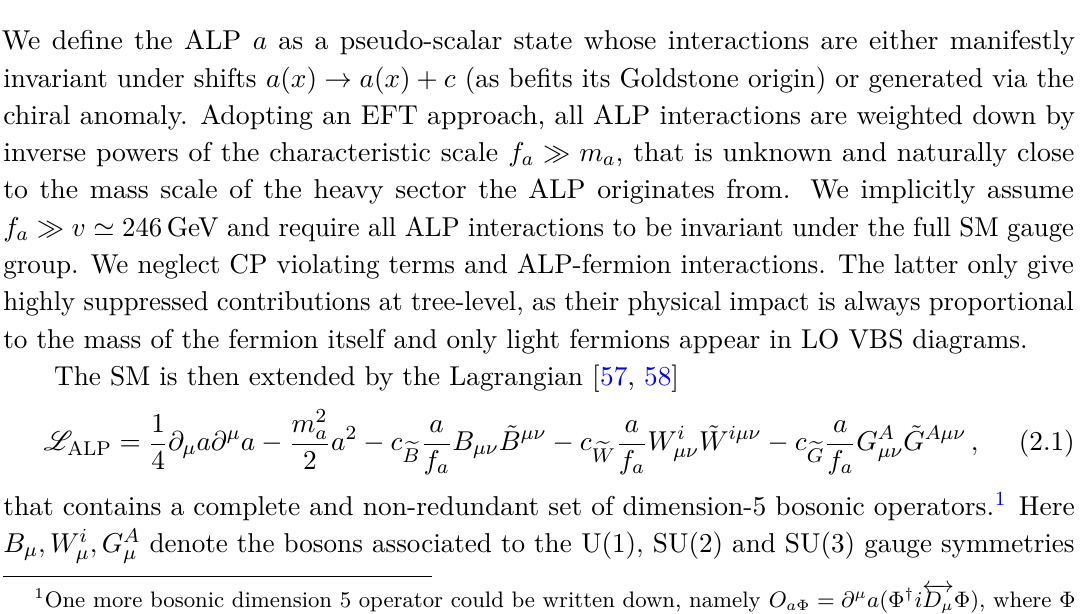
lines represent both quarks and antiquarks. In the last diagram, the final state quarks can be emitted from any of the outgoing